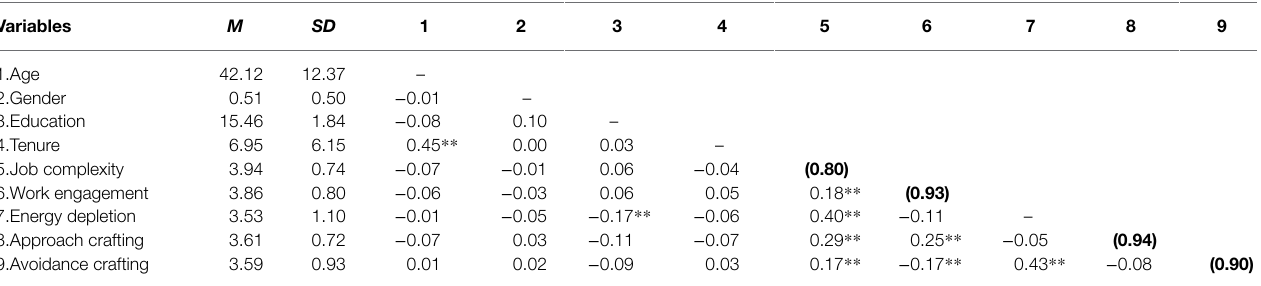
TABLE 2 | Means, standard deviations, and correlations among study variables. Variables